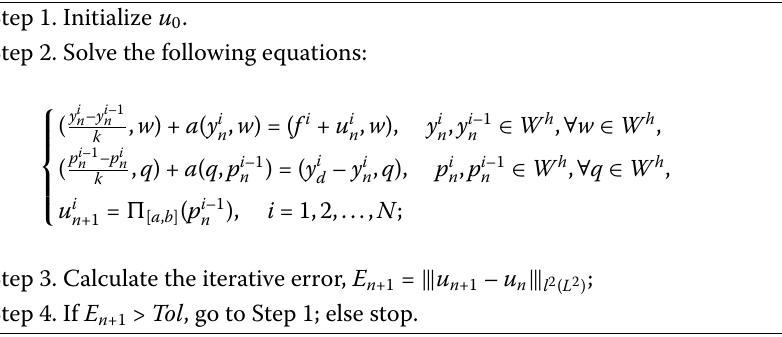
Algorithm 5.1 VD approximation algorithm